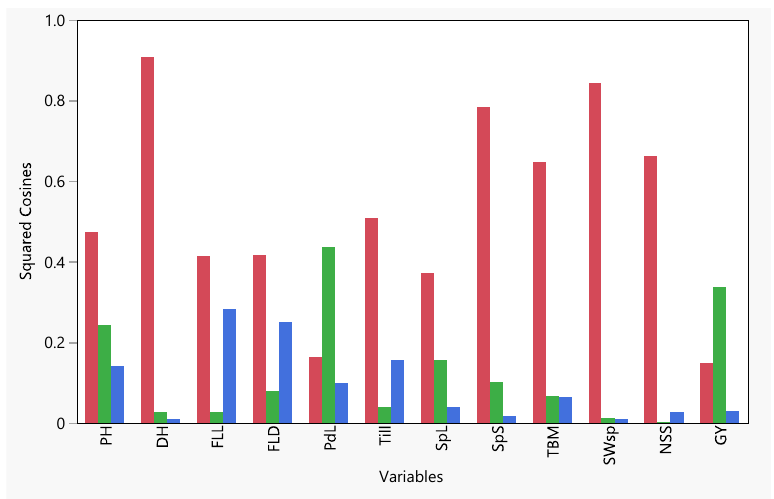
Figure 4. Squared cosines associated with the principal components for twelve studied traits of 101 parental wheat genotypes and RILs.